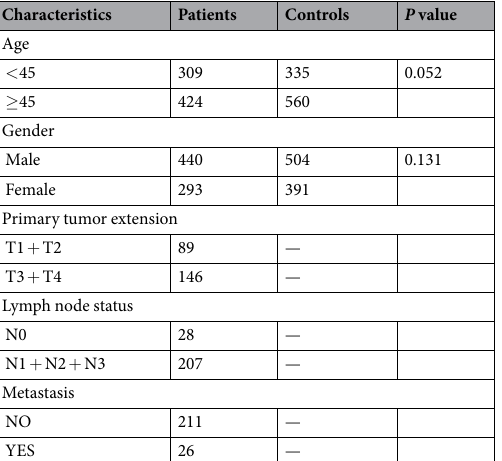
— Table 1. Characteristics of nasopharyngeal carcinoma patients and